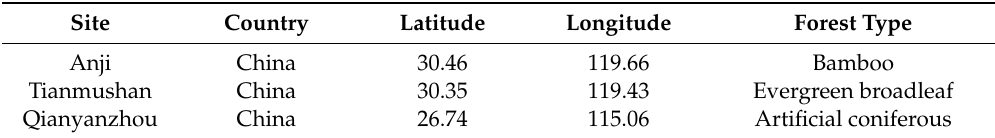
Table 2. The location of flux towers for the three kinds of forest.